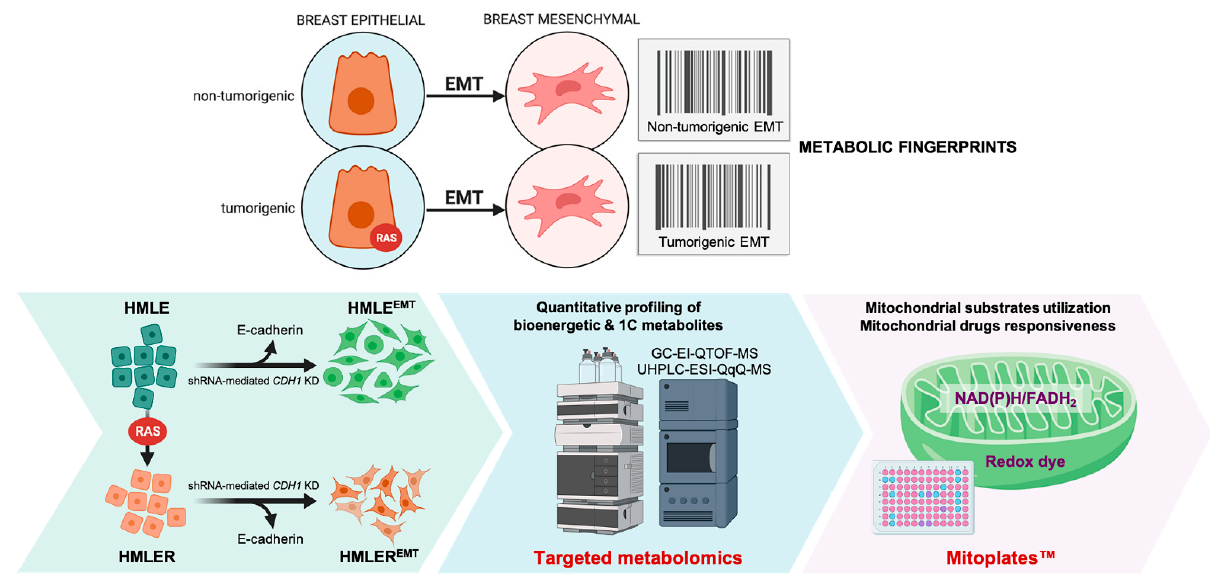
Figure 1. Metabolic fingerprinting of non-tumorigenic and tumorigenic EMT: a metabolomic and mitochondrial phenotyping approach. HMLE/HMLER cells induced for EMT upon loss of E-cadherin and their parental counterparts (HMLE/HMLER) were simultaneously subjected to quantitative screening for bioenergetic ( n = 30) and 1C ( n = 14) metabolites and qualitative phenotyping of multiple mitochondria energy substrates ( n = 31, at low millimolar concentrations (2–5 mmol/L)) and mitochondrial drugs ( n = 22) using the Mitoplate™ S-1 and I-1 assays, respectively. (shRNA: small hairpin RNA; KD: knock-down).